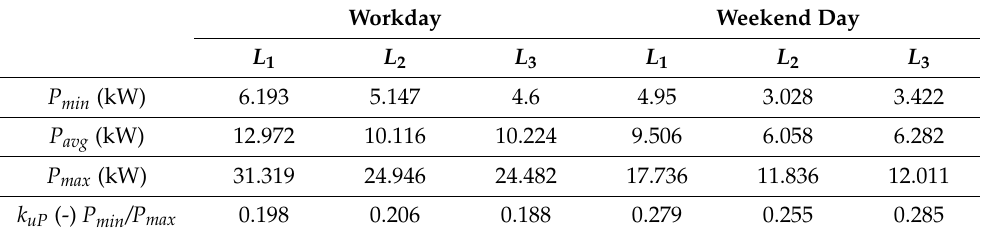
Table 1. The main values of active powers.